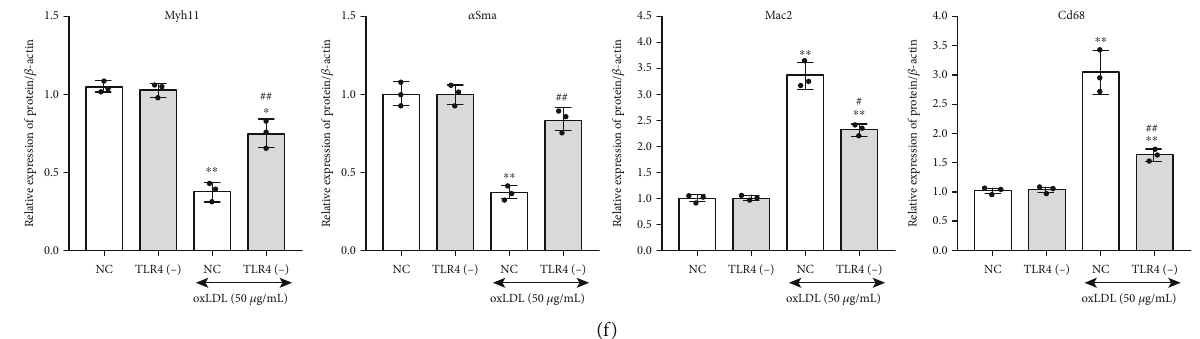
Figure 4: Knockdown of Tlr4 suppressed oxLDL-induced lipid accumulation, ROS and mitochondrial superoxide production, and regulated related gene activation and expression. Tlr4 was knockdown by siRNA transfection within VSMCs. (a) The Tlr4-speci fi c [Tlr4(-)] and negative (NC) siRNA were transfected into VSMCs for 72 hours, and the knockdown e ffi ciency was detected. ( n = 3 per group, results were expressed as mean ± SD ; compared with the NC group by Student ’ s t -test, ∗∗ P < 0 : 01 .) Tlr4(-) or NC VSMCs were treated with or without oxLDL (50 μ g/mL) for 48 hours. (b) Lipid accumulation (Nile red stain, orange). (c) ROS (DCFH-DA, green) and (d) mitochondrial superoxide (MitoSOX, red) were measured. ( n = 5 per group, results are expressed as mean ± SD ; ∗ P < 0 : 05 , ∗∗ P < 0 : 01 , as compared with oxLDL-untreated NC group; # P < 0 : 05 , ## P < 0 : 01 , as compared with oxLDL-treated NC group.) (e) Tlr4(-) or NC VSMCs were treated with or without oxLDL (50 μ g/mL) for 48 hours; western blot was conducted to measure oxidative stress-associated genes, VSMC contractile phenotype markers (Myh11 and α Sma), and foam cell markers (Mac2 and Cd68). And β -actin served as an internal reference gene to normalize protein expression. (f) All the western blot results were calculated using grayscale value. ( n = 3 per group, results are expressed as mean ± SD ; ∗ P < 0 : 05 , ∗∗ P < 0 : 01 , as compared with oxLDL-untreated NC group; # P < 0 : 05 , ## P < 0 : 01 , as compared with oxLDL-treated NC